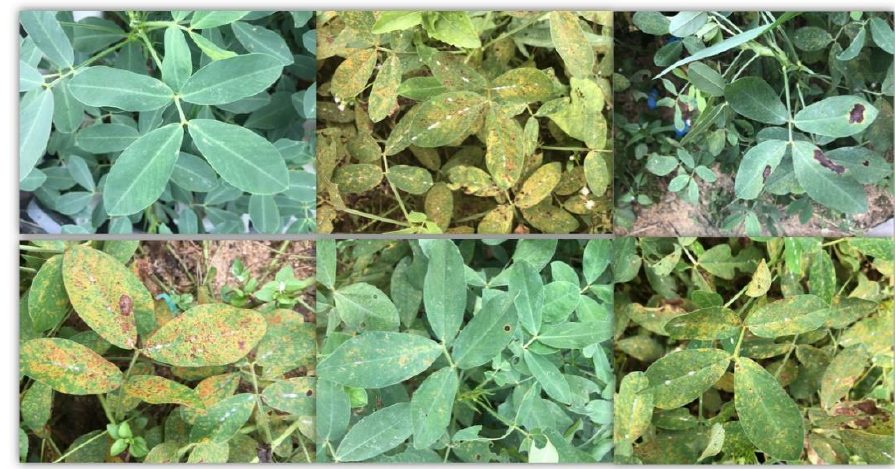
Figure 1. The original images of peanut leaves collected by mobile phone.